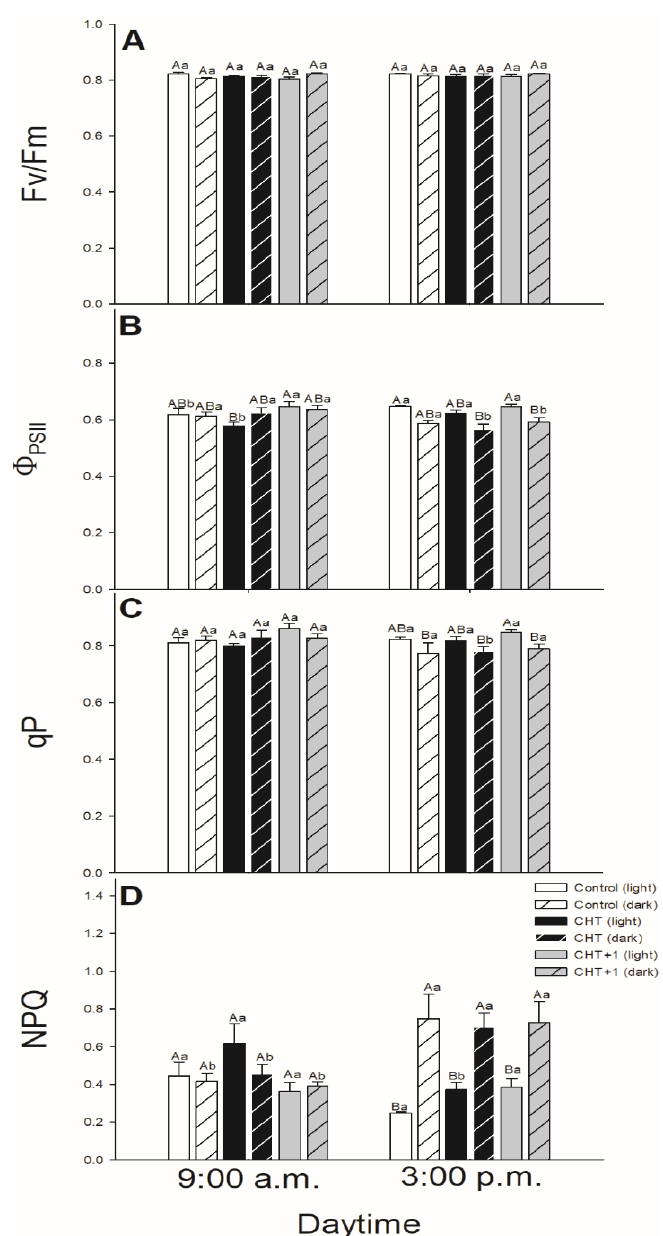
Figure 8. Changes in the chlorophyll a fluorescence parameters [Fv / Fm ( A ), Φ PSII ( B ), qP ( C ), NPQ ( D )] of leaves of intact tomato plants treated foliar with 100 µ g mL –1 chitosan (CHT) dissolved in the experimental bu ff er (1 mM AA, 10 mM MES / TRIS, 10 mM KCl, 0.1 mM CaCl 2 , pH 6.15) in the morning: 08:00 hrs, keeping under light (normal columns) or in continuous darkness (stripped columns)]. Measurements were disposed at constant times after treatments (09:00 and 15:00 hrs). Means ± SE, n = 3. Means were analyzed by two-way ANOVA, significant di ff erences among the data were analyzed by Holm–Sidak test. Mean values significantly di ff erent at P < 0.05 were signed with di ff erent letters, upper case letters indicate the e ff ects of the treatment at the same daytime, and lower case letters indicate the e ff ects of the daytime under the same treatment. (Control: treatment with 1 mM Acetic acid bu ff er (AA); CHT: treatment with 100 µ g mL –1 chitosan in experimental bu ff er containing AA; CHT + 1: untreated distal leaf level from the CHT-treated